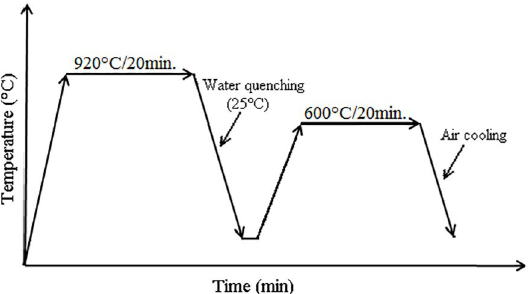
Figure 2. Schematic representation of the heat treatments used in this